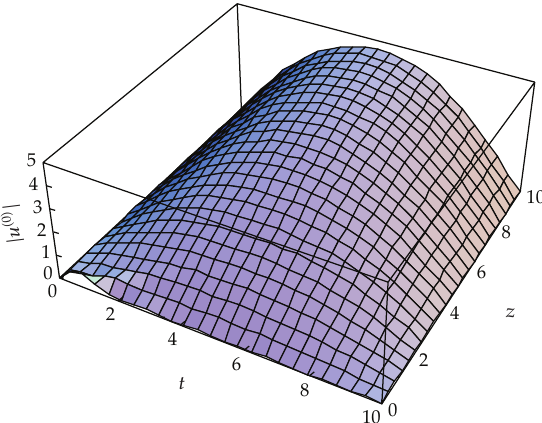
Figure 28: The zero-order approximation of | u (cid:3) 0 (cid:4) | at α (cid:8) 1, T (cid:8) 10, γ (cid:8) 02 with considering only one term in the series (cid:3) M (cid:8) 1 (cid:4)